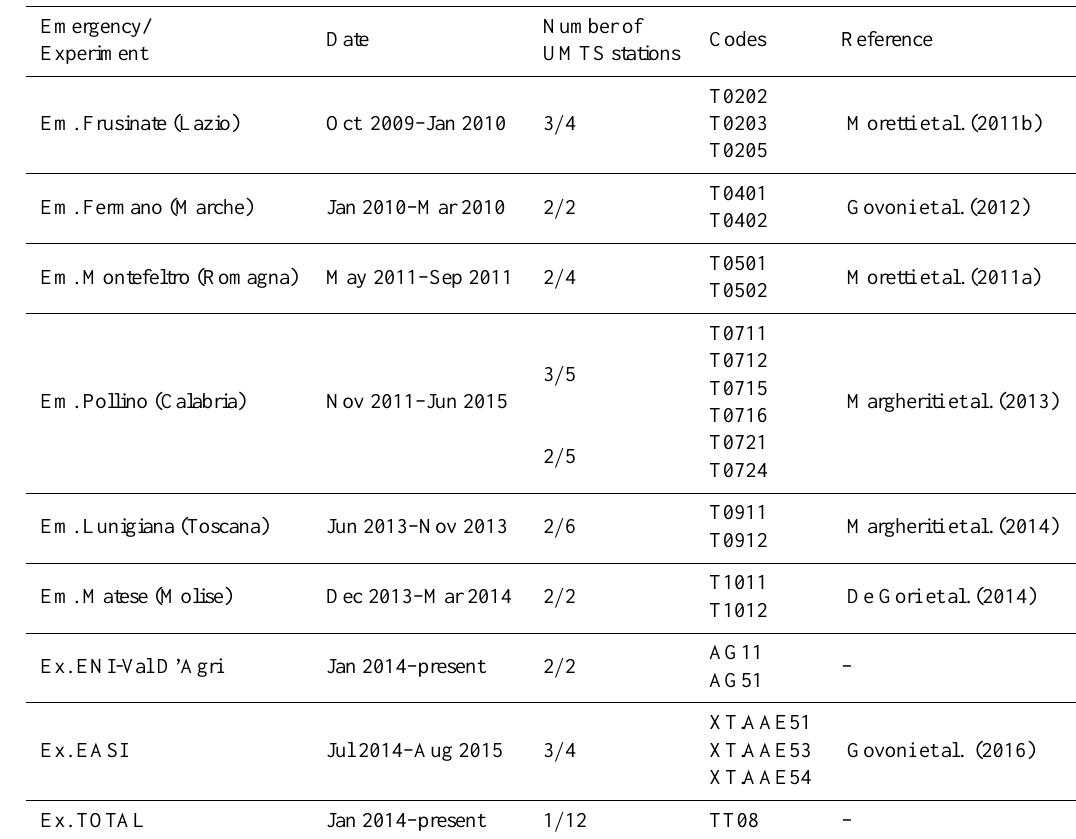
Table 1. List and details of all INGV temporary experiment and emergency networks deploying real-time seismic stations since 2009.